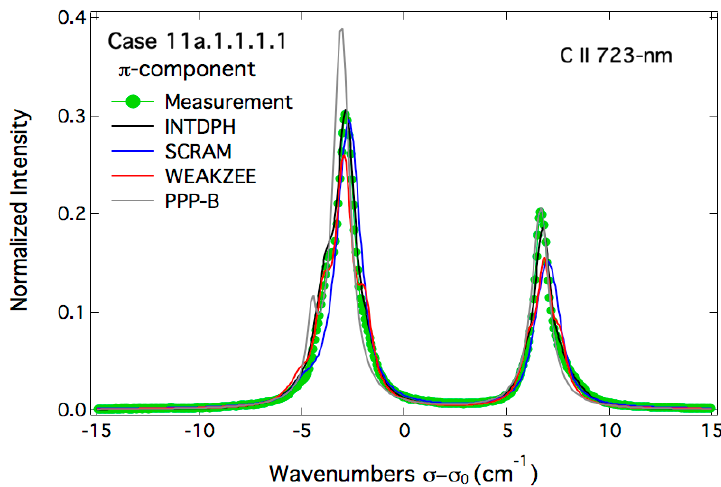
Figure 10. Fitting attempts of the π -polarized experimental spectrum of the C II 723-nm line as measured in LHD. All spectra are normalized to